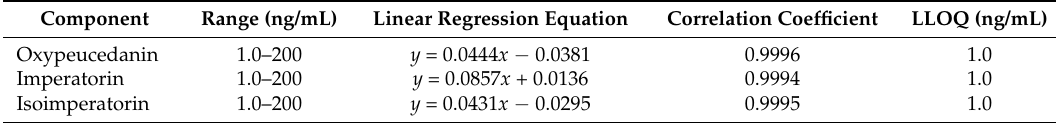
Table 1. Linearity and calibration curves of oxypeucedanin, imperatorin, and